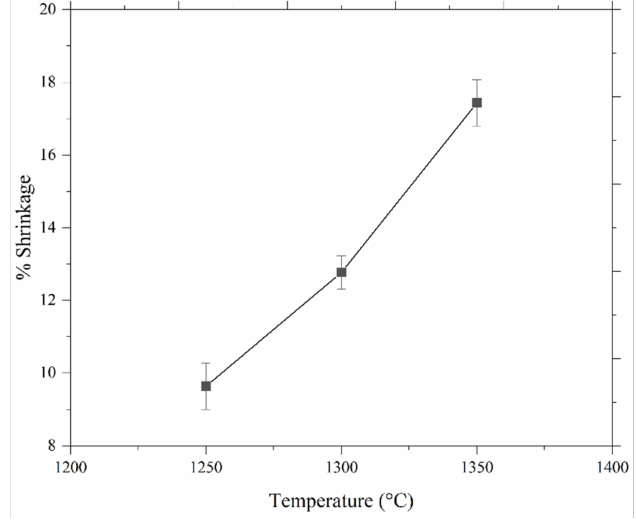
Figure 8. Shrinkage occurred in bi-materials at different temperatures with a dwelling period of 3 h. The SEM images of the 17-4PH/zirconia micro-parts sintered at 1250 ◦ C, 1300 ◦ C, and 1350 ◦ C with a holding period of 3 h are exhibited in Figure 9. Based on Figure 9a, the par- tially bonded interface of 17-4PH and zirconia had cracks when the micro-sized specimen was sintered at 1250 ◦ C. During sintering, mismatch strains are produced at the interface as a consequence of the predisposition of different layers of materials to shrinkage at different rates [36]. Such differences in shrinkage rates cause delamination, pore-band formation, and cracking in the bonding region due to bi-axial mismatch stresses [37]. The partial bonding of the specimen was improved when the temperature was enhanced to 1300 ◦ C, as displayed in Figure 9b. As shown in Figure 9c, 17-4PH and zirconia had a strong bond when sintering was performed at 1350 ◦ C; this was attributed to an adequate reduction in mismatch shrinkage. Figure 10 depicts EDS mapping. Iron (Fe), zirconium (Zr), chromium (Cr), oxygen (O), yttrium (Y), and nickel (Ni) were present at the 17-4PH/zirconia inter- face of the micro-sized component. The inter-diffusion of elements at the interface was caused by their higher affinity toward the oxygen of the zirconia ceramic, which ultimately caused bonding between 17-4PH and zirconia due to oxide layer formation [38]. Figure 11 illustrates the microstructures of the 17-4PH/zirconia micro-sized components sintered at different temperatures with the existence of pore bands. As Ni and Cr possess greater diffusion coefficients in Fe than Zr diffusing from the opposite side, vacancies develop in the vicinity of the 17-4PH stainless steel portion, creating pore bands